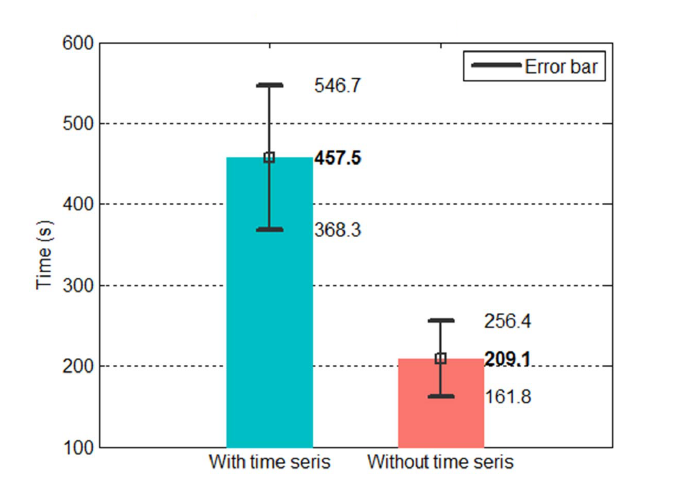
Figure 20. Training time of the dual-network method with and without time